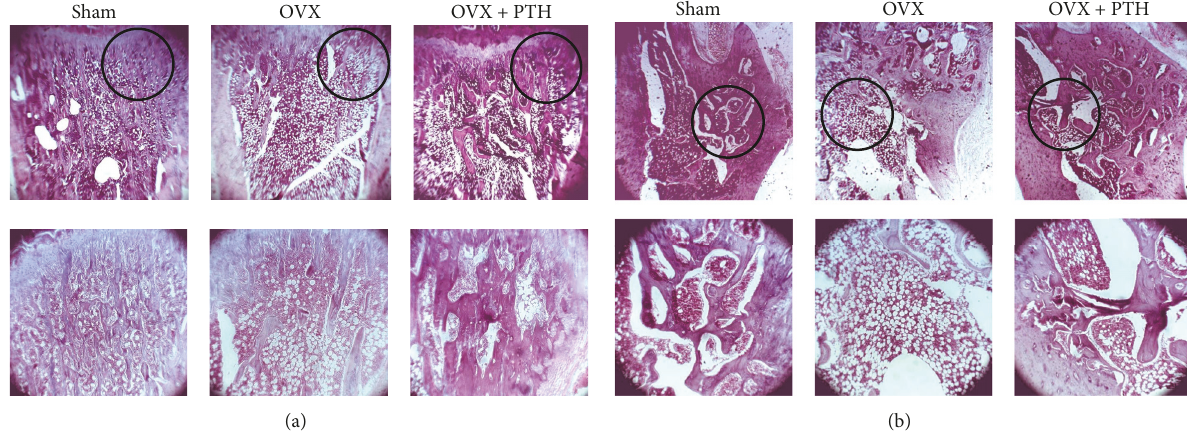
Figure 4: Therapeutic treatment experiment: examples of bone marrow cellularity histology (hematoxylin and eosin stain) of Sham, OVX, and OVX + PTH (a) tibiae and (b) femurs bones at 11 weeks after operation. OVX revealed a significantly greater amount of adipocytes compared with the Sham and PTH treated rats. Slides were visualized by Motic AE31 inverted microscope, magnification × 4/ ×